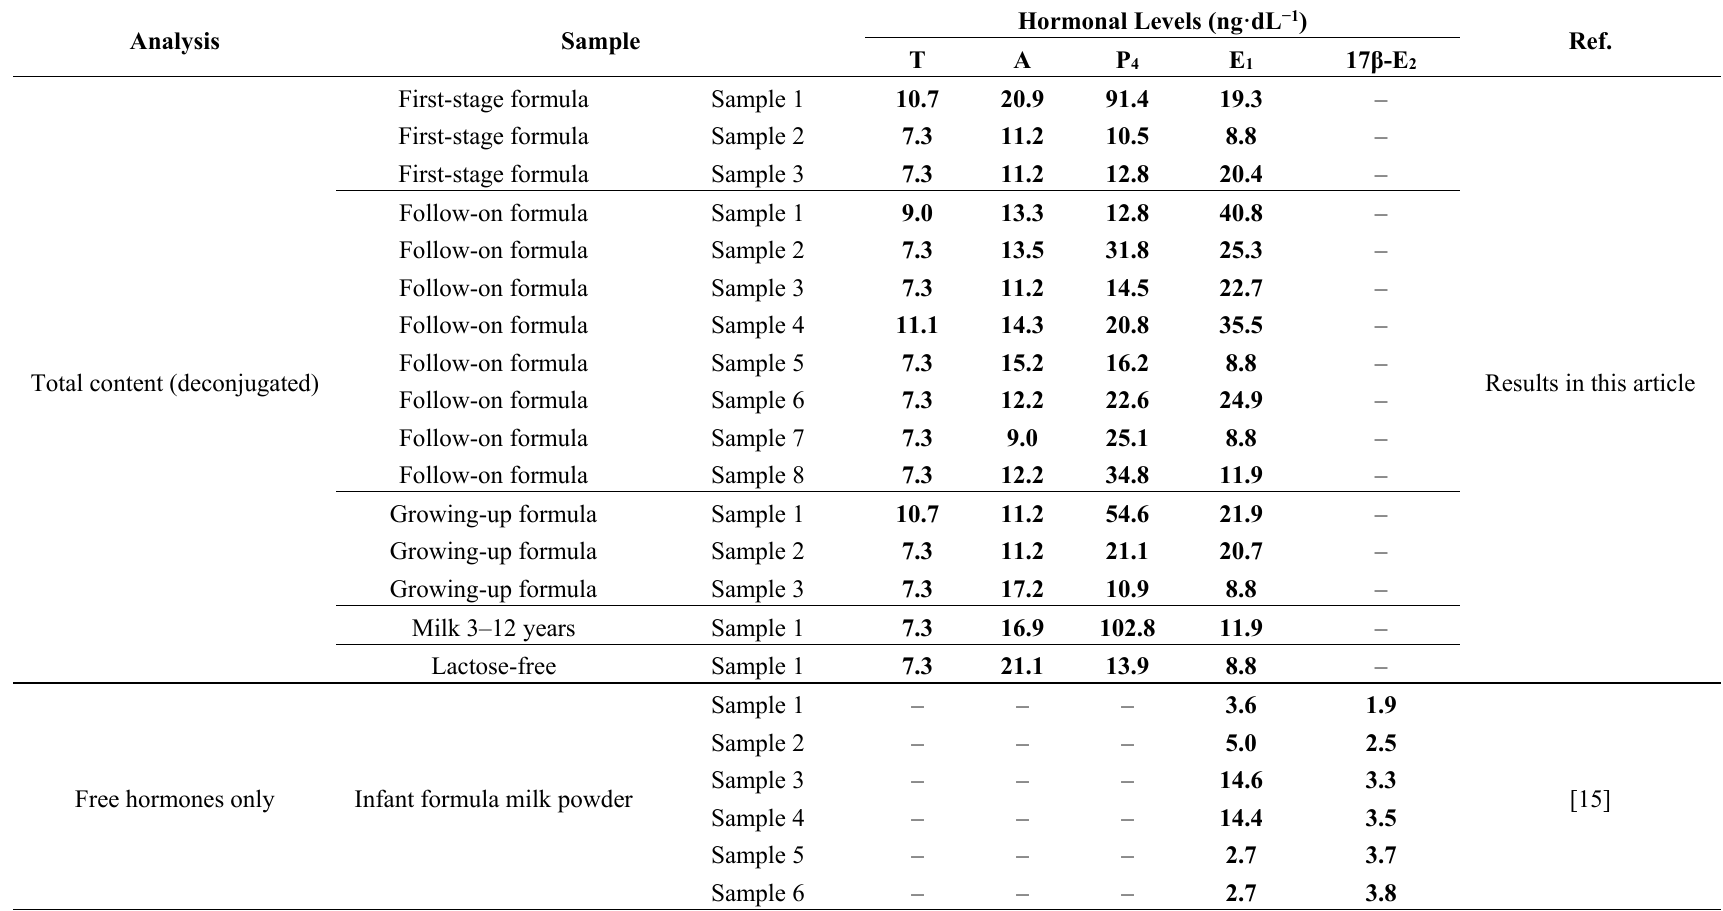
Table 2. Mean concentrations of five natural steroid hormones, determined in different infant formulas, milk for children, bovine milk and human breast milk.